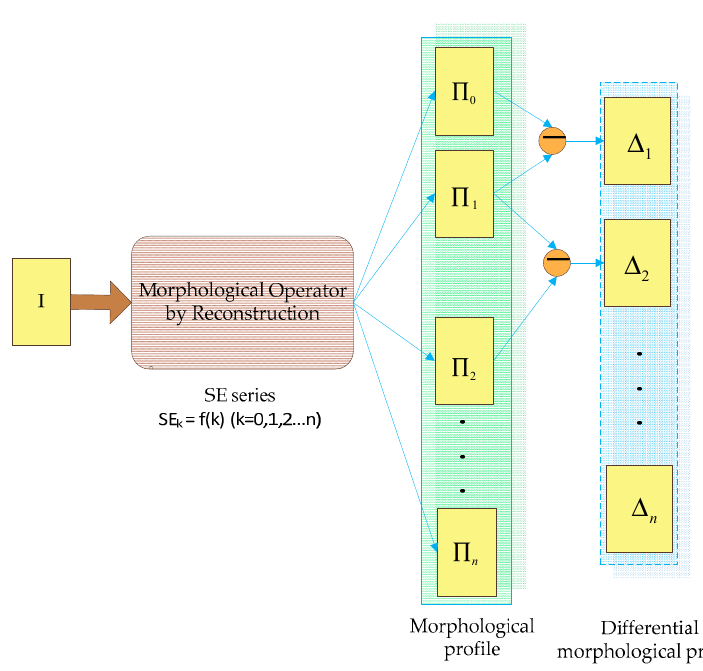
Figure 2. Illustration of the basic principle of the DMP.